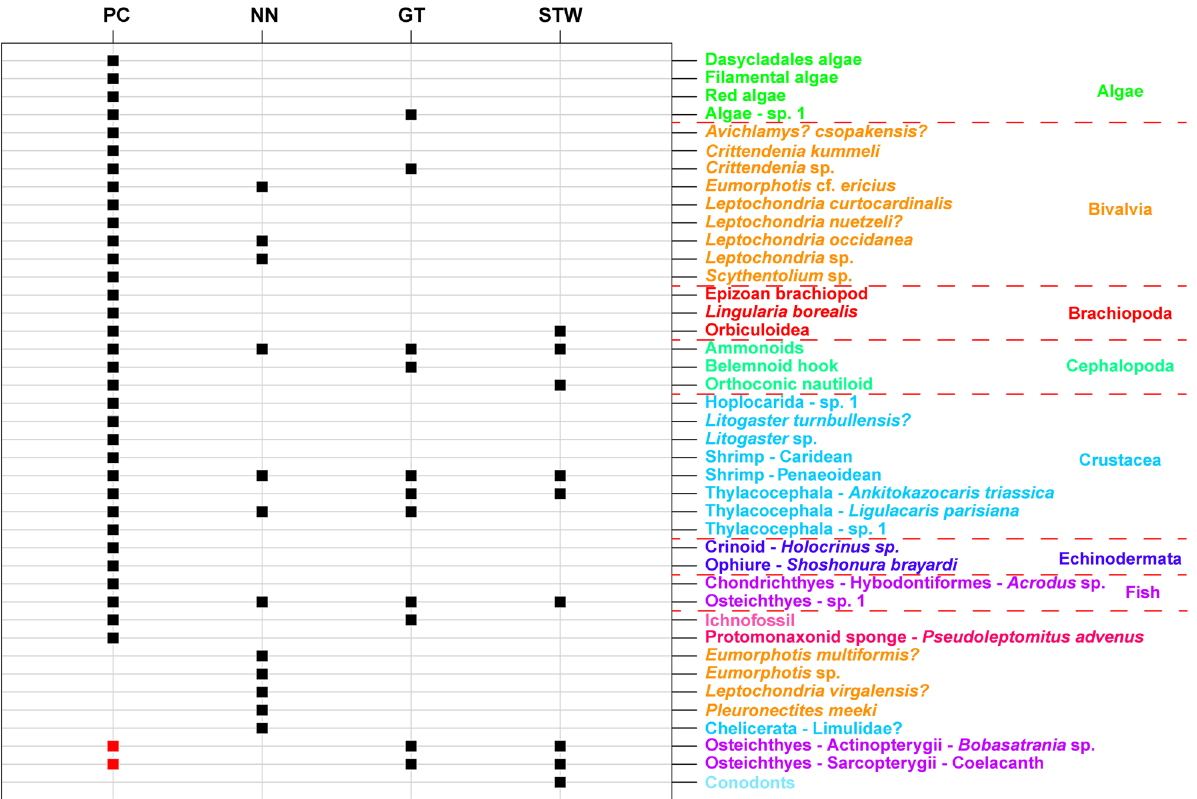
Figure 6. Taxa occurrences for Paris Canyon (PC), NoName (NN), Georgetown (GT) and Stewart Canyon (STW) assemblages used in quantitative analyses. A first analysis was conducted using only formally identified taxa (black squares). A second analysis was computed considering that Bobasatrania sp. and coelacanth also occur in Paris Canyon (red squares). The figure was computed using R software (R Core Team